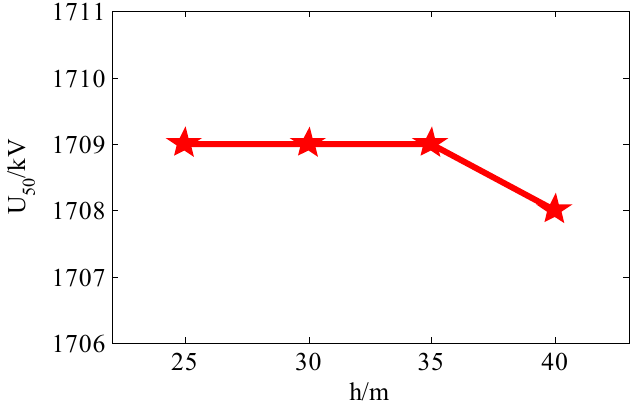
Figure 4. U 50 of conductor-tower gaps with different heights.